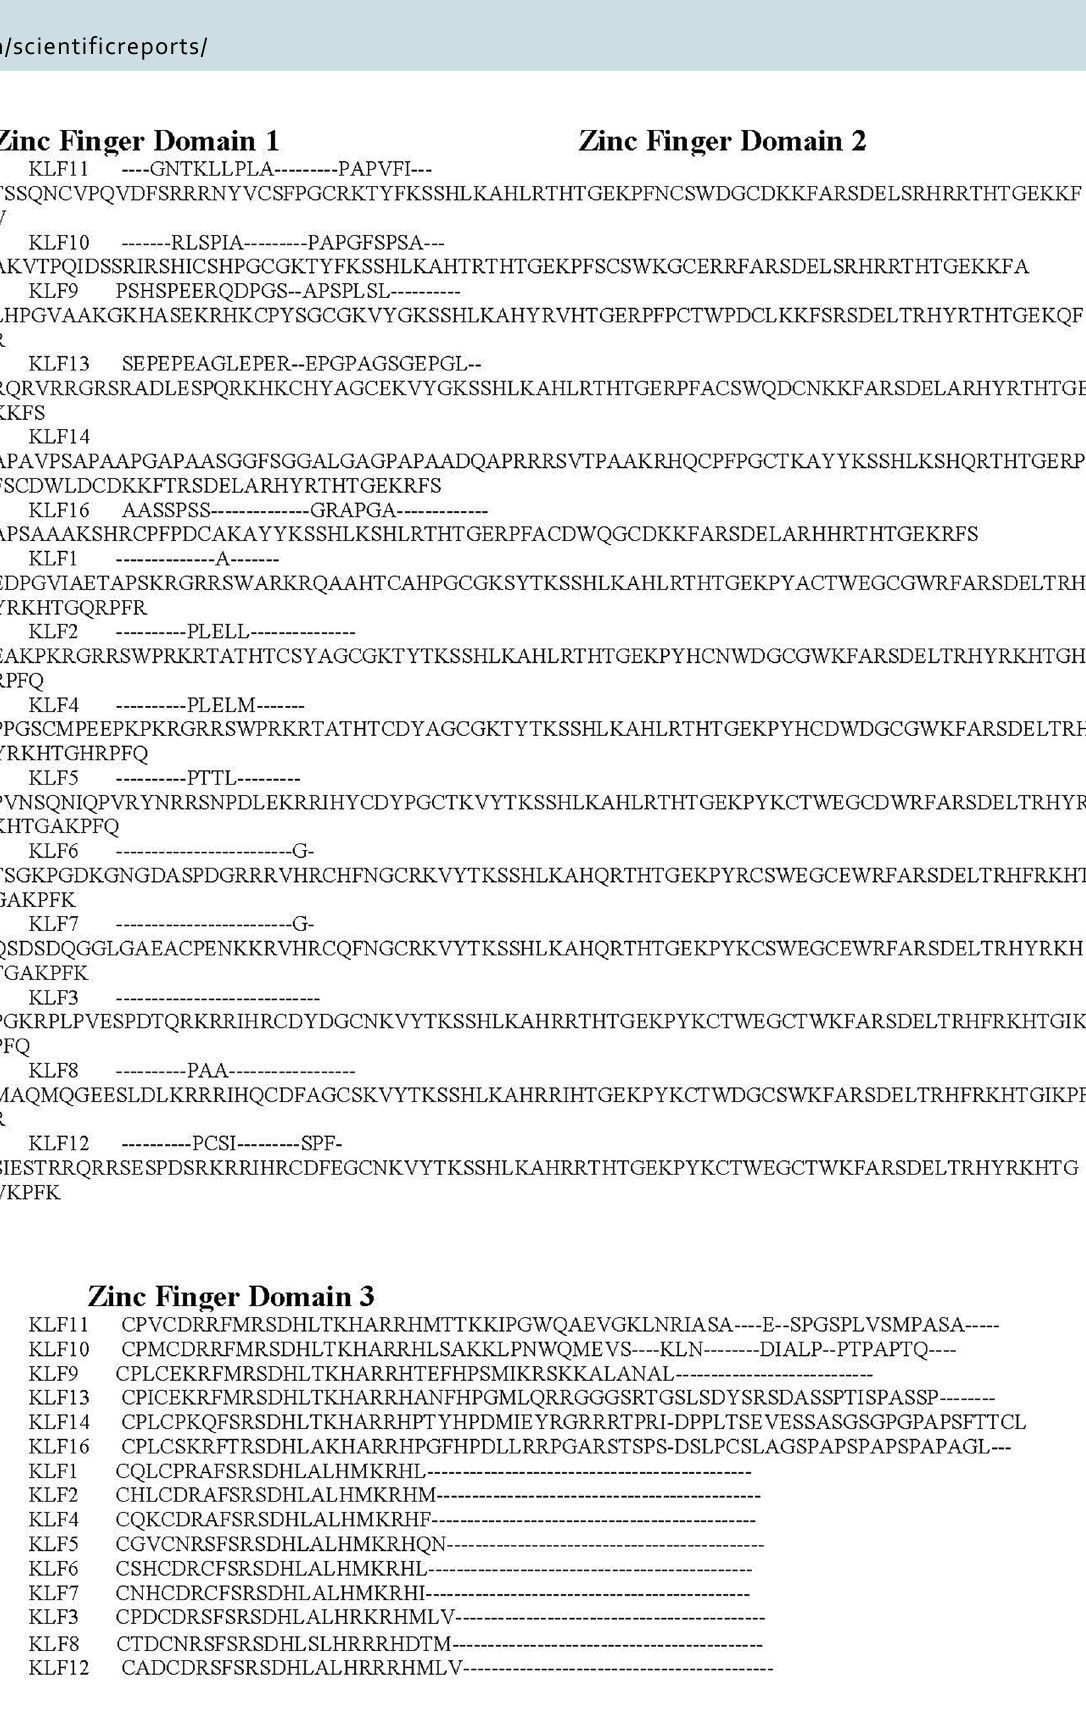
Figure 8. Sequence alignment of Kruppel like factors depicting conserved domains obtained from Clustal Omega. Certain sequence alignments have been deleted for formatting, Zinc figure domain 1(labeled as green), zinc figure domain 2 (labeled as purple) and zinc figure domain 3 (labeled as blue) have been